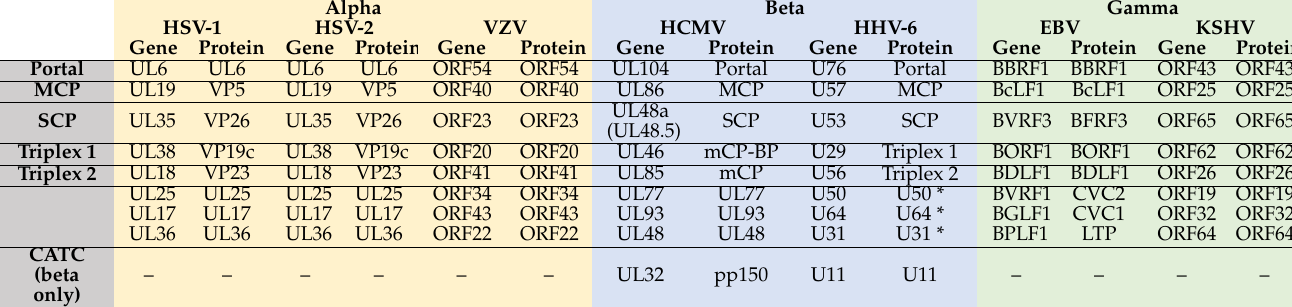
Table 1. Gene and protein names for each capsid component from human herpesviruses with known capsid